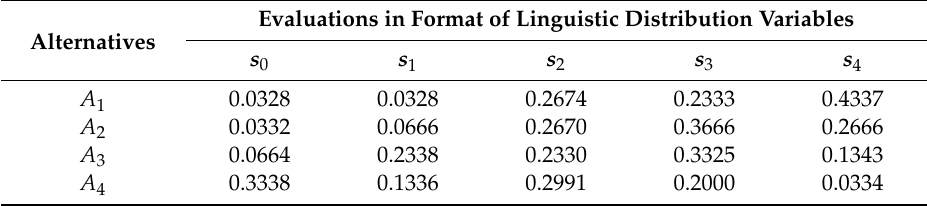
Table 3. The linguistic distribution evaluations on criterion C 3 .